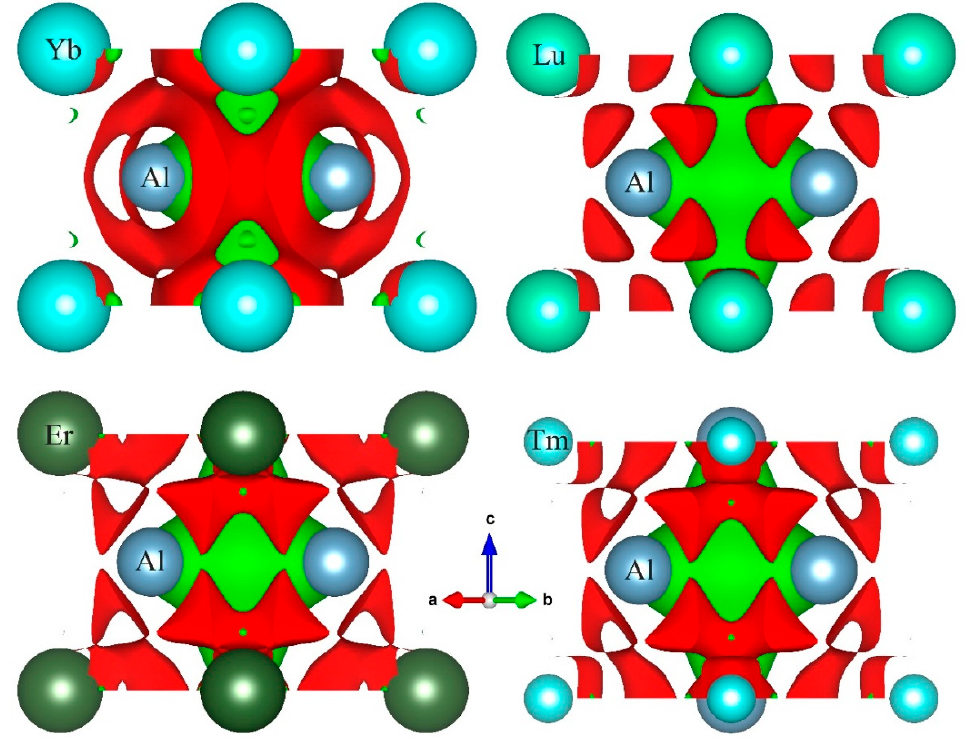
Figure 5. 3D map of the differential charge density of L1 2 -Al 3 M (M = Yb, Lu, Er, and Tm) com- pounds.